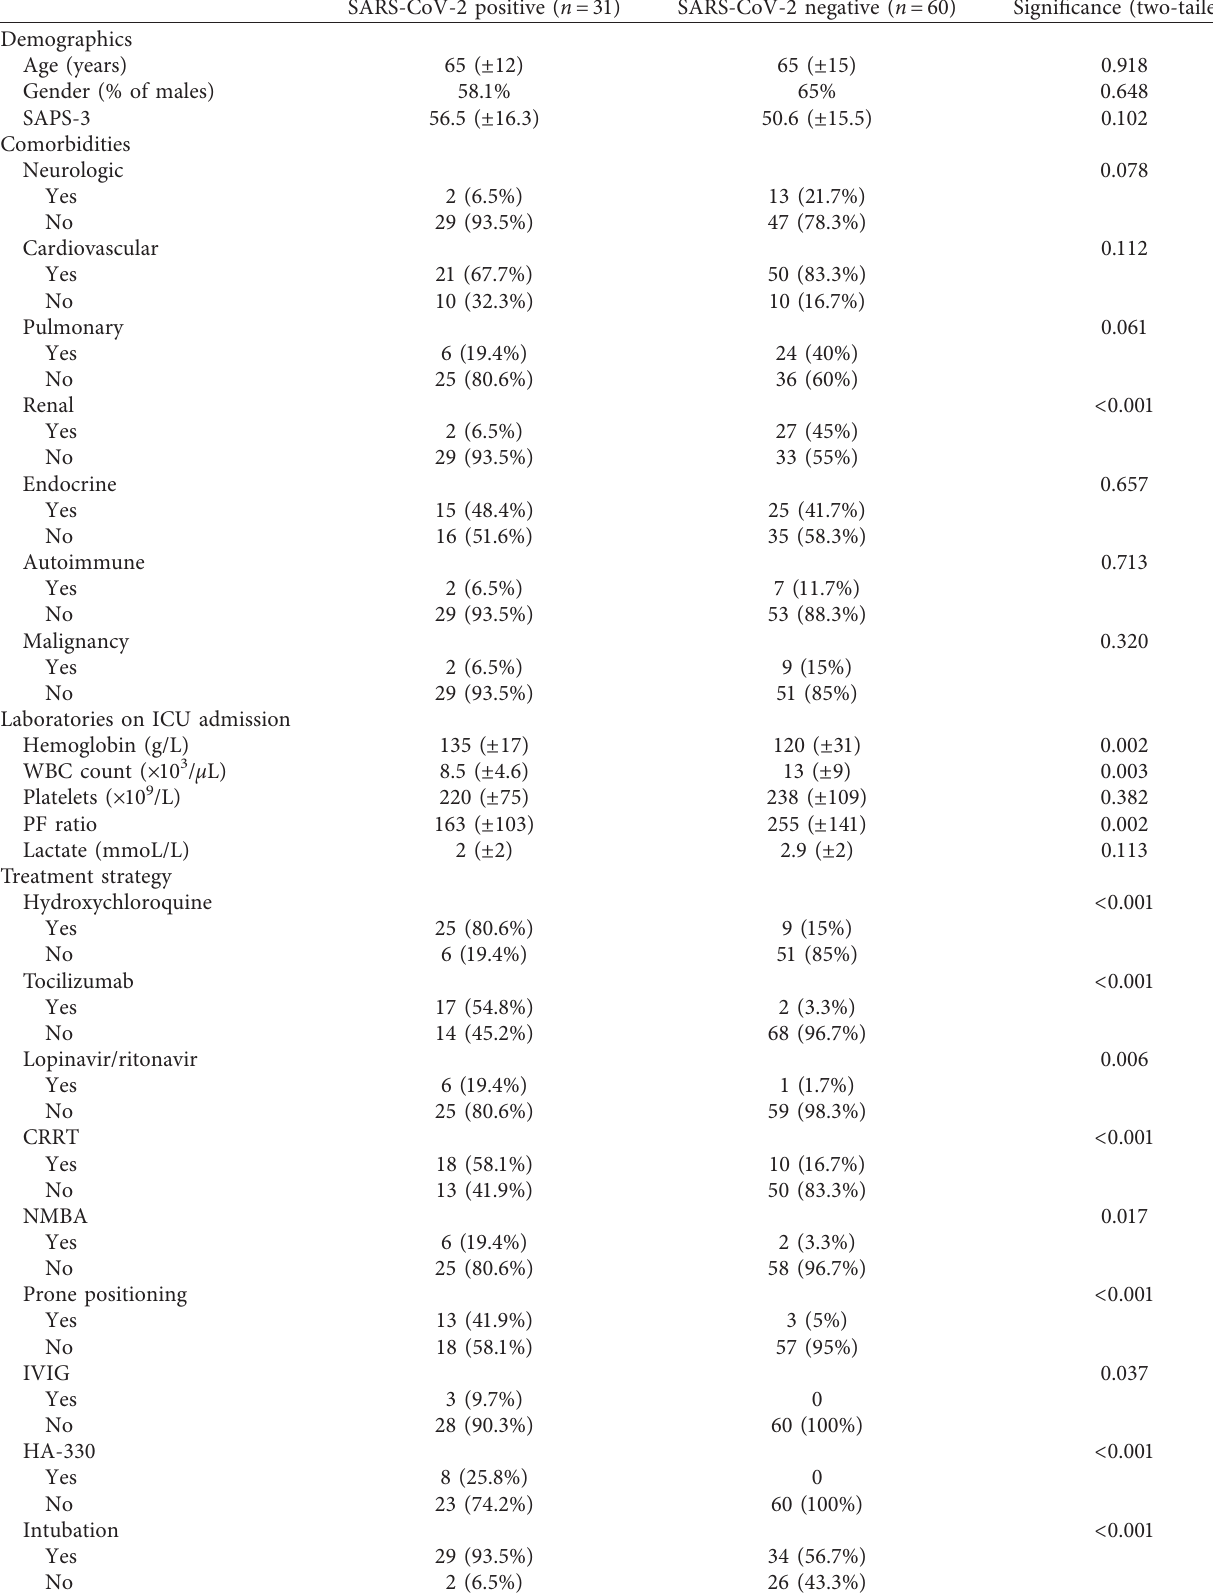
Table 2: Variables and SARS-CoV-2